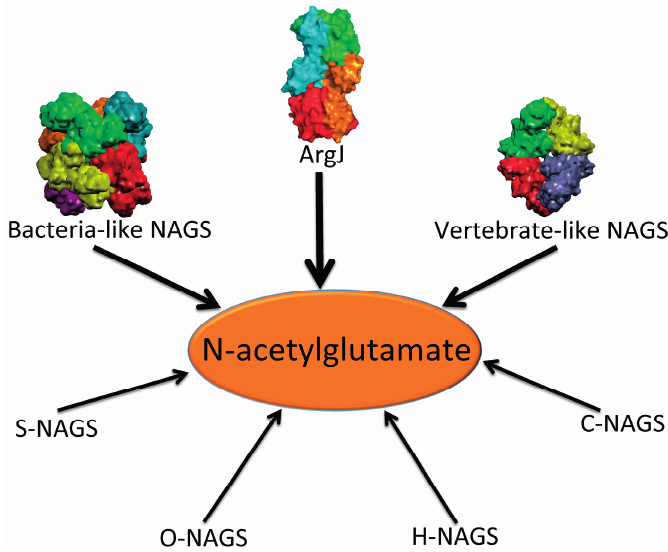
Figure 1. Enzymes that produce N -acetylglutamate. Bacteria-like N -acetylglutamate synthase (NAGS) include the classical bacterial NAGS and plant NAGS, which have hexameric architectures, represented by NAGS from Neisseria gonorrhoeae (PDB code 2R8V). Vertebrate-like NAGS include the bifunctional bacterial NAGS/K, mammalian NAGS, fungal NAGS and other vertebrate NAGS, which have tetrameric architectures, represented by the bifunctional NAGS/K from Maricaulis maris (PDB code 3S6G). These two groups of NAGS are typical NAGS enzymes in that they have both AAK and NAT domains and catalyze the formation of NAG from AcCoA and glutamate. They are the focus of this review. ArgJ is the mono- or bi-functional ornithine acetyltransferase that catalyzes the production of NAG from acetylornithine and glutamate (mono-) and AcCoA and glutamate (bi-). This enzyme is likely to be a heterotetramer, represented by argJ from Mycobacterium tuberculosis (PDB code 3IT4). Other atypical NAGSs exist in certain bacteria but no structures have been determined so far. The short version of NAGS (S-NAGS), for example argA from M. tuberculosis has only NAT domain. The NAGS encoded by the argO gene of Campylobacter jejuni (O-NAGS) consists of 146 amino acids, which broadly relate to the GNAT family. H-NAGS has been identified in Moritella abyss and Moritella profunda with argH fused to the N-terminal end of the NAT related domain. C-NAGS is a novel type of NAGS, recently identified in Corynebacterium glutamicum , whose sequence does not have any relationship to other known